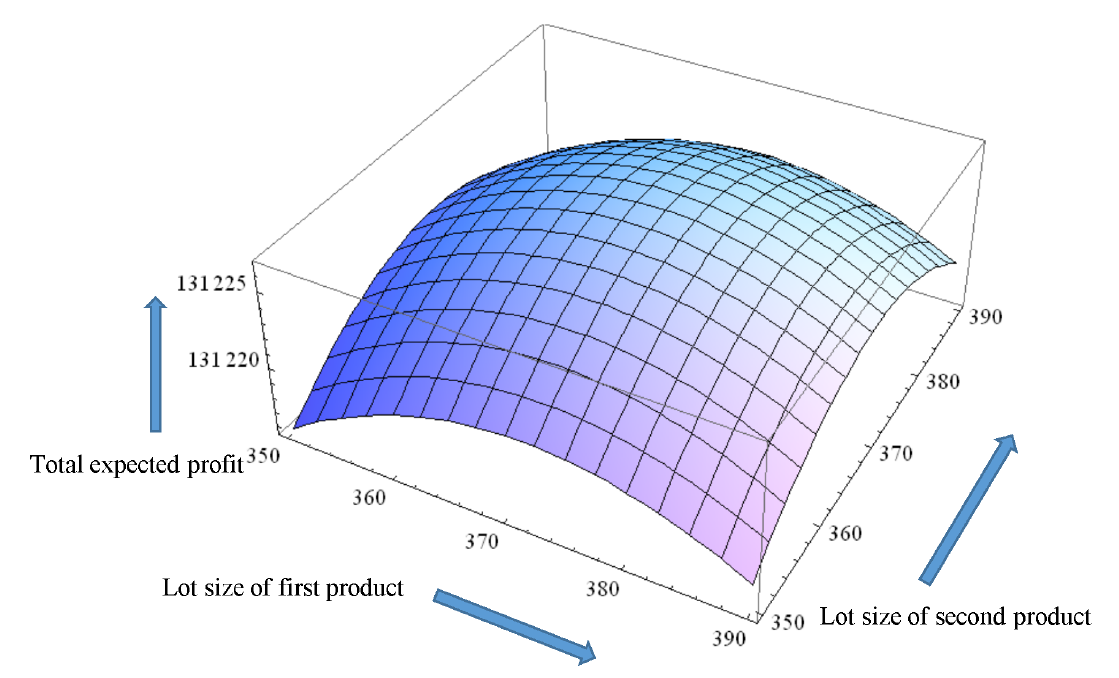
Figure 5. Expected total profit (ETP) versus lot size of two products ( Q 1 , Q 2